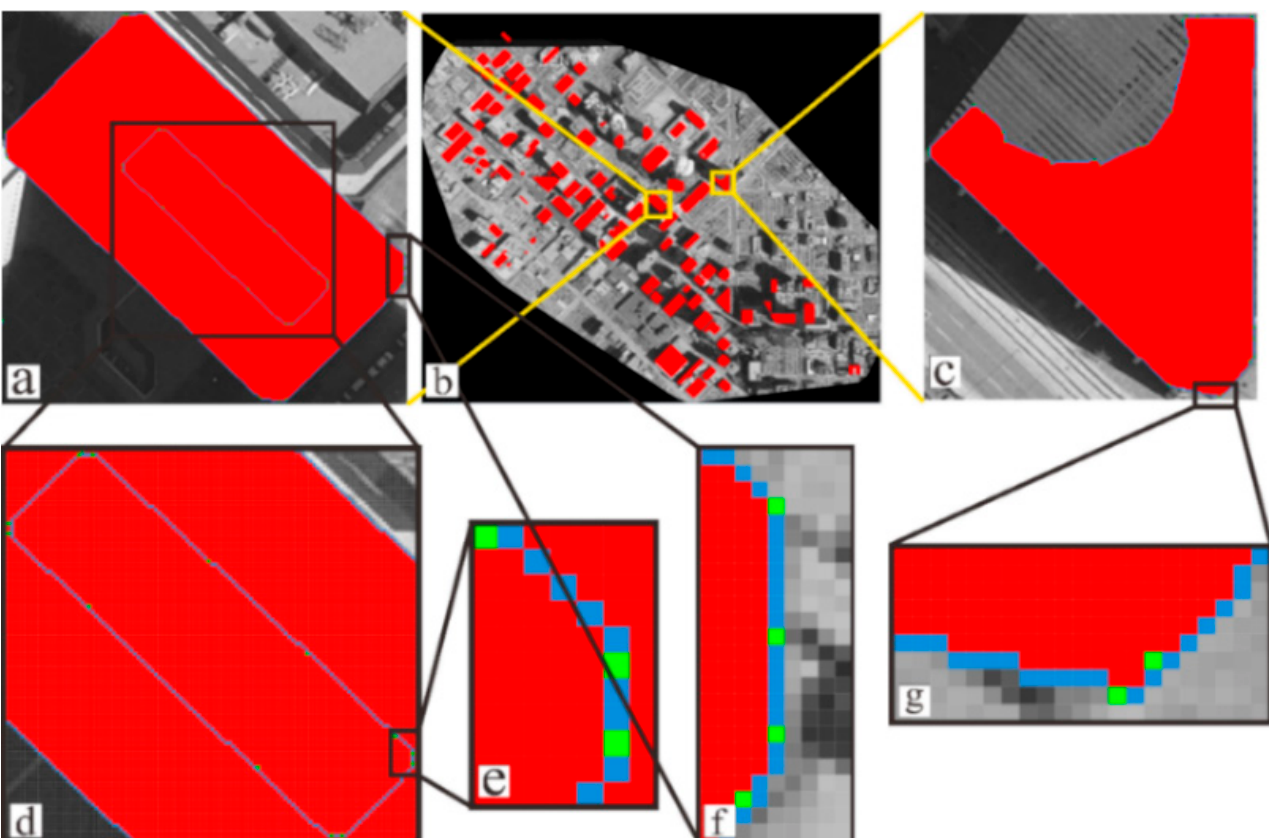
Figure 26. Acquisition of horizontal projection polygon corner points: ( a ) building model consisting of two voxels; ( b ) graph of the corner point detection results; ( c ) building model consisting of a single voxel; ( d – f ) local enlargement of ( a ); ( g ) local enlargement of ( c ).